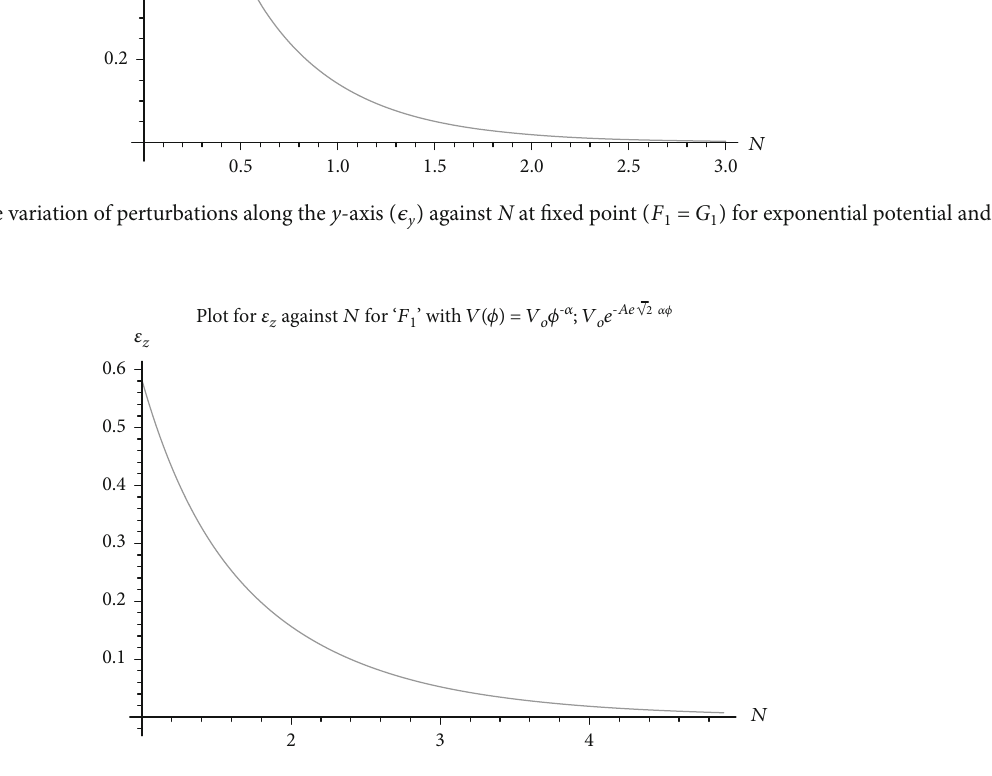
) against N at fi xed point ( F 1 = G 1 ) for exponential potential and inverse z